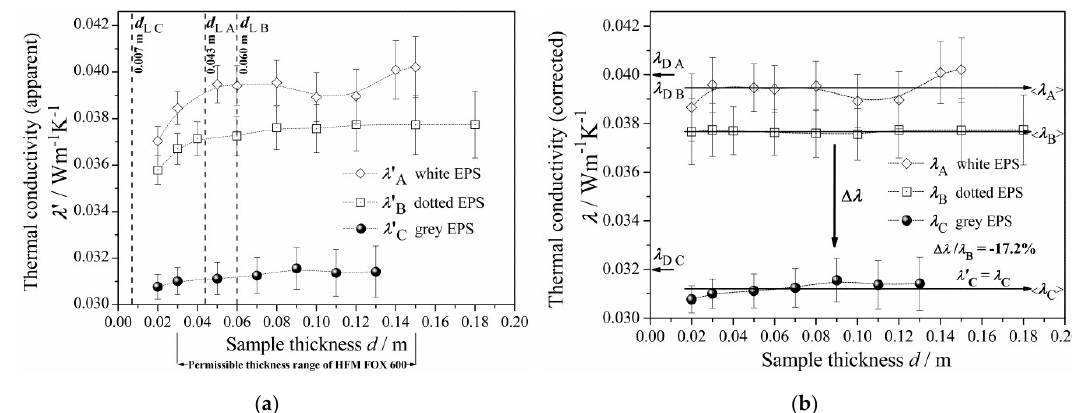
Figure 4. ( a ) The apparent thermal conductivity coefficient λ’ versus the panel thickness d for the EPS A, B, and C products, as measured at T m = 10 °C. The error bars correspond to the expanded uncertainties U ( λ ’). The vertical dashed lines, labelled by d LA , d LB , and d LC , show the corresponding thickness limits; ( b ) The corrected thermal conductivity coefficient λ at T m = 10 °C versus the panel thickness d for the EPS A, B, and C. The error bars correspond to the expanded uncertainties U ( λ ). The horizontal right arrows indicate the average conductivity < λ > values from Table 3. The left arrow on the level 0.04 indicates λ DA and λ DB (as declared for the A and B products), while λ DC appears at the 0.032 level. The vertical down arrow Δ λ shows the effect of graphite microparticles (GMP) on thermal conduction. Referring EPS C to EPS B, the relative drop of conductivity achieved was 17.2%.